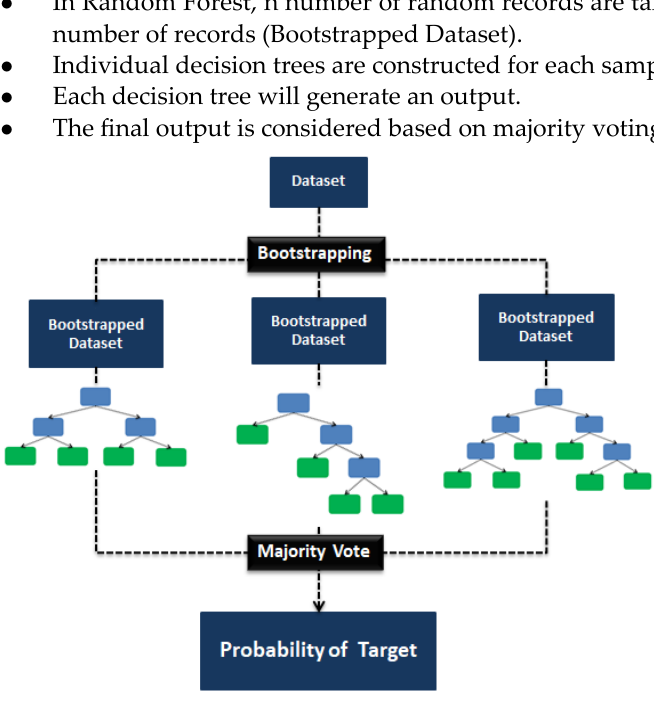
Figure 3. Random Forest modeling process